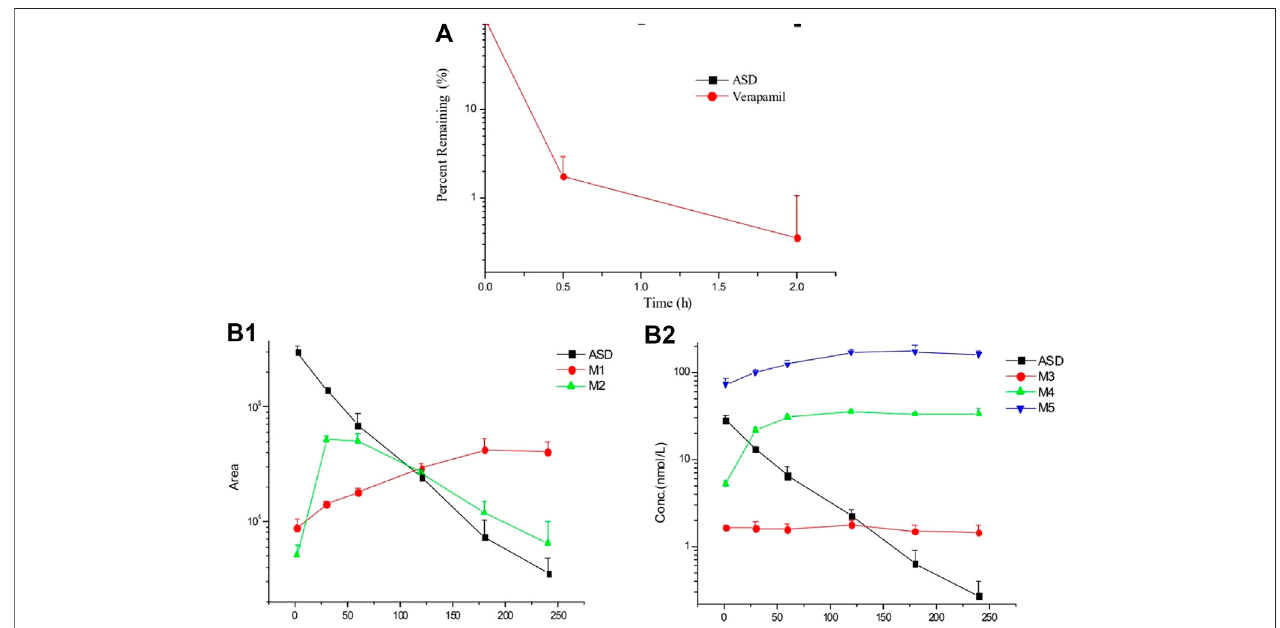
FIGURE 4 | Mean plasma concentration-time pro fi les of ASD in different groups ( n (cid:2) 5).